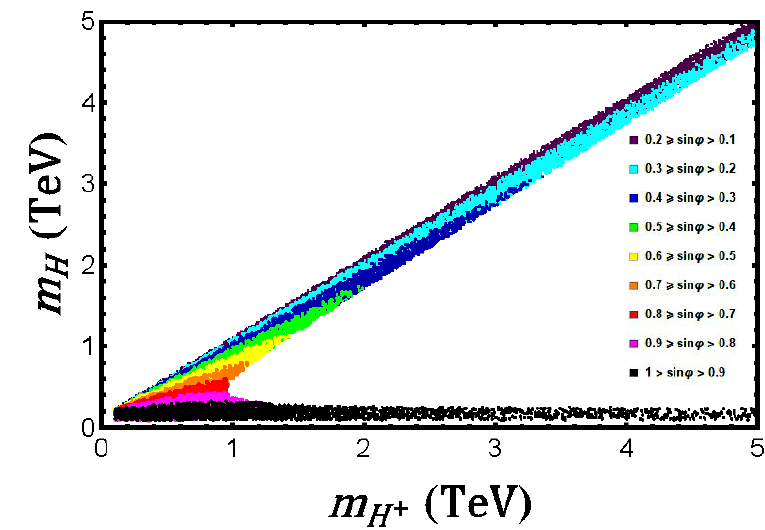
Figure 6 . T -parameter constraint at the 2 (cid:27) con(cid:12)dence level in the heavy charged and neutral Higgs mass plane in the Zee model. Here we have set the light charged scalar mass m Di(cid:11)erent colored regions correspond to di(cid:11)erent values of the mixing angle sin ’ between the charged Higgs bosons.